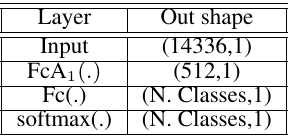
Figure 2. Examples of images taken randomly from both datasets. (a) UC-MERCED and (b) NWPU-RESISC45 .